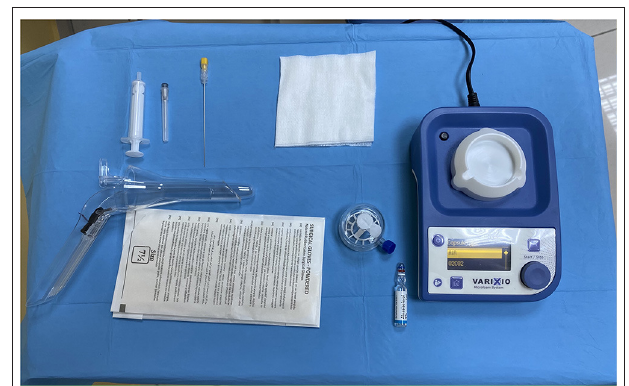
FIGURE 1 | The equipment needed to perform the procedure: an automated device, open-ended anoscope, a 20 Gauge needle, a 5-ml syringe, and polidocanol 3%